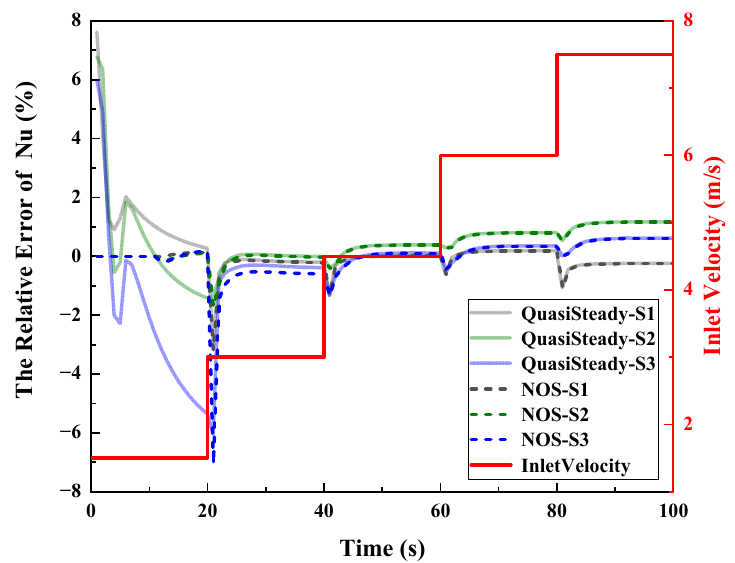
Figure 10. The relative errors of the average Nu of the three rectangular block surfaces obtained using the quasi-steady algorithm and the novel optimization strategy after adding velocity perturbations at different time periods relative to the results of the traditional coupling algorithm.